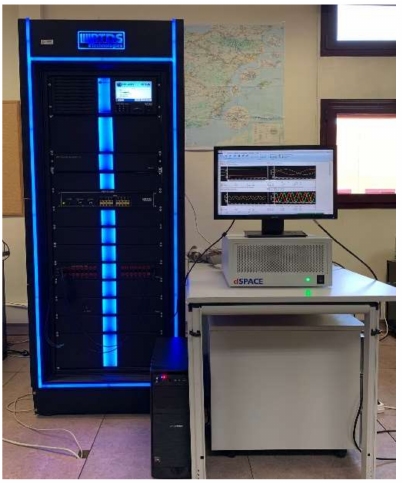
Figure 14. Hardware in the Loop experimental set-up.